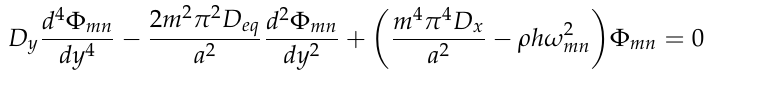
Figure 5. First six modes of the equivalent model.